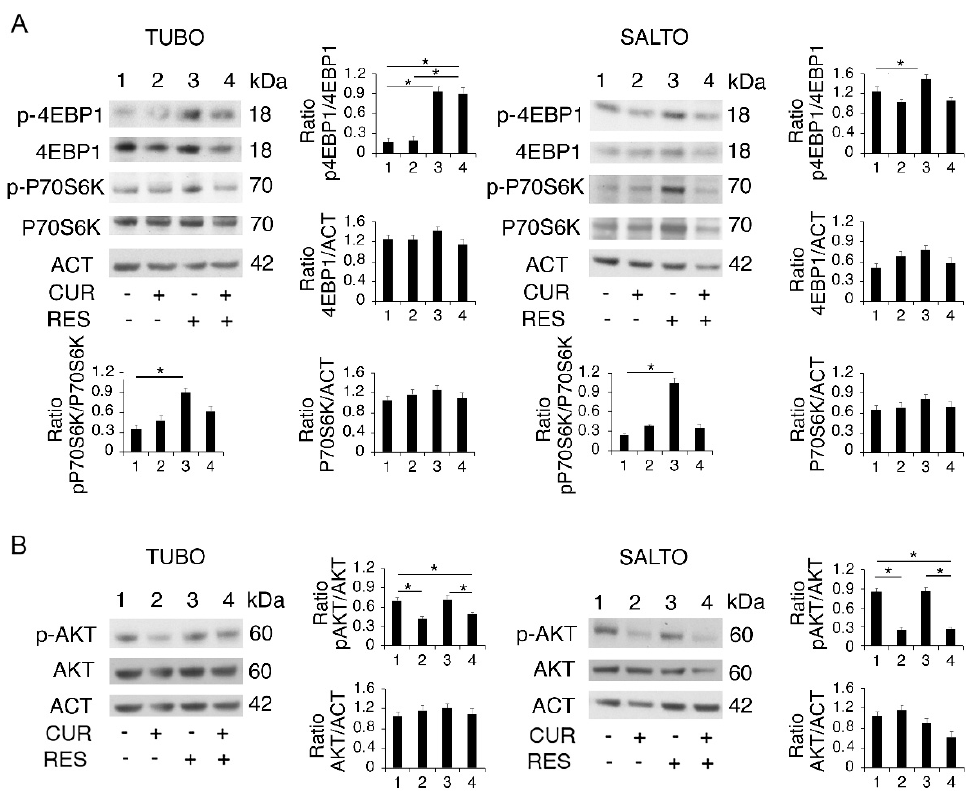
Figure 3. Curcumin and resveratrol affect PI3K/AKT/mTOR activation. ( A ) 4EBP1 and P70S6K mTOR targets and ( B ) AKT phosphorylation as evaluated by Western blot analysis in curcumin-, resveratrol- and curcumin/resveratrol-treated TUBO and SALTO cell lines, after 48 h of treatment. One representative experiment is shown. Histograms represent the mean plus standard deviation of densitometric analysis of three independent experiments. Actin was used as a loading control. * p value <0.05.